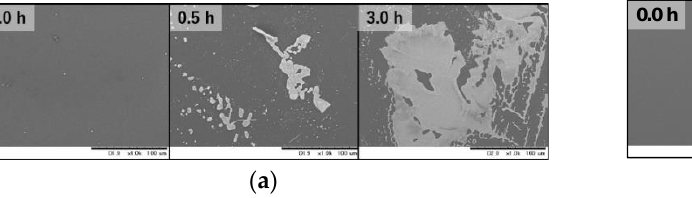
Figure 8. SEM image of the glass substrate immersed in AgNO 3 solution. ( a ) With biofilm formation; ( b ) Without biofilm formation.